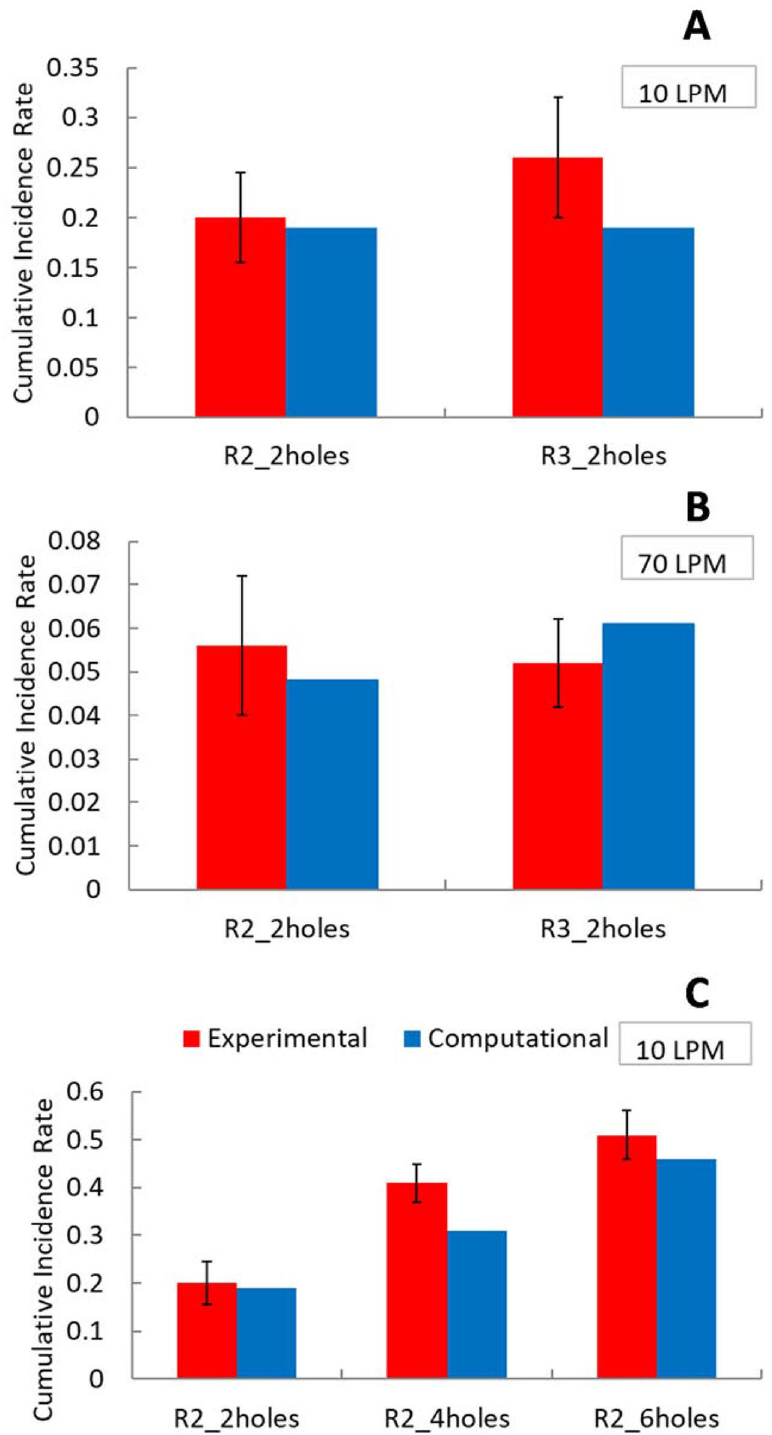
Figure 8. Cumulative incidence rate for experiments and simulations for flat plate with R2 and R3 respirators for breathing rate of 10 LPM; n = 3 for